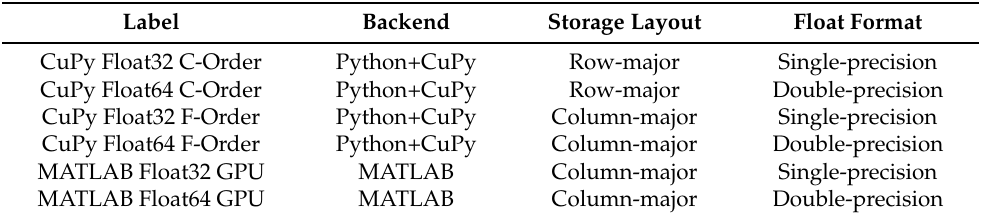
Table 4. Implementation of the statistical tolerance analysis implementations using a